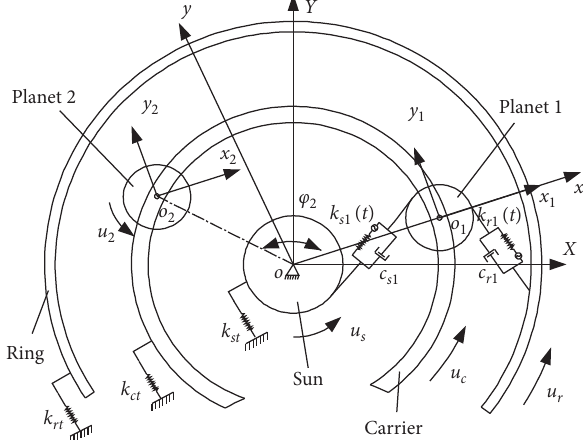
Figure 2: Torsional dynamical